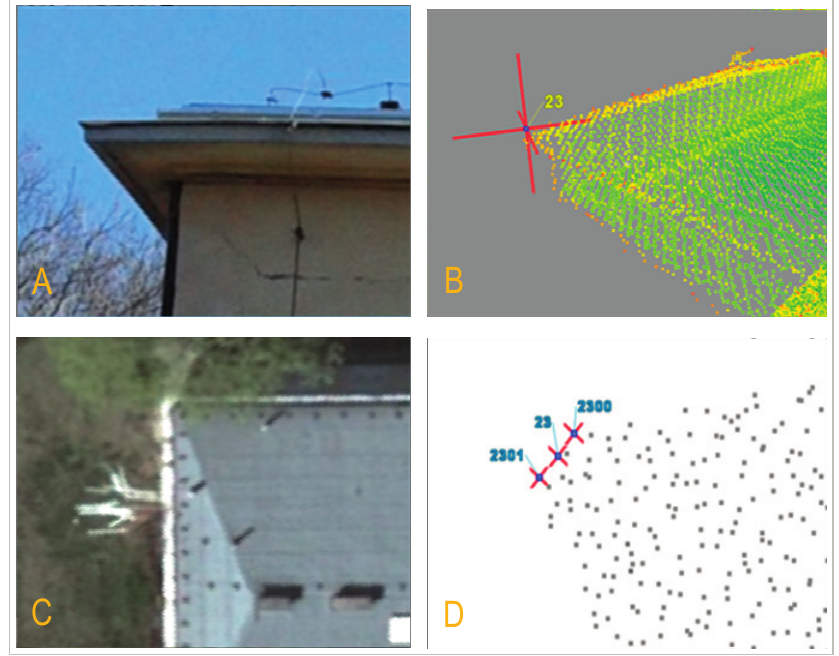
Figure 2. The view of building edge. ( A ) terrestrial image; ( B ) TLS point cloud perspective view; ( C ) aerial image; ( D ) ALS point